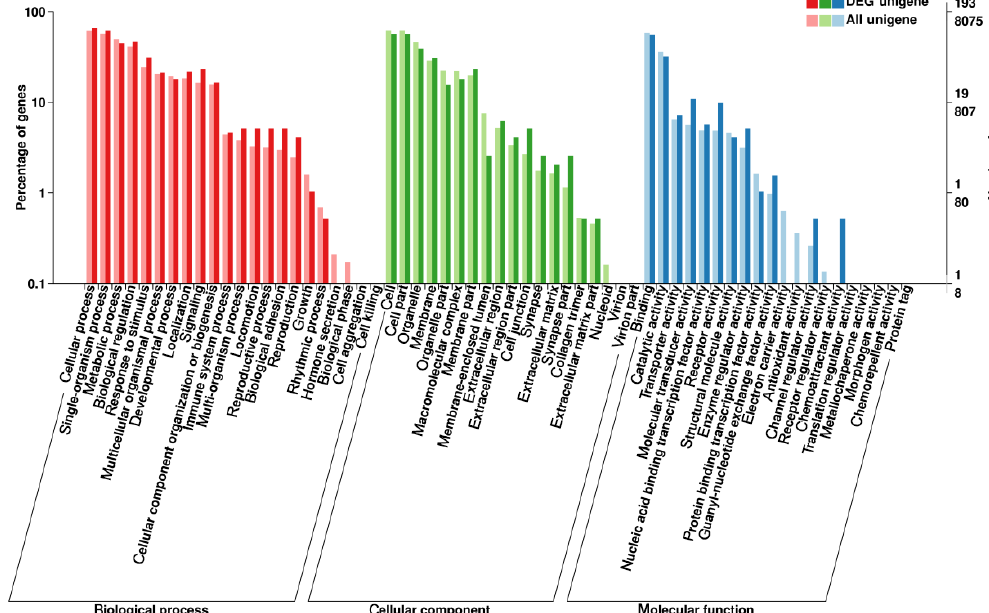
Figure 4. GO annotation of differentially expressed genes. The abscissa is the GO classification, the left vertical axis is the percentage of the number of genes and the right is the number of genes.